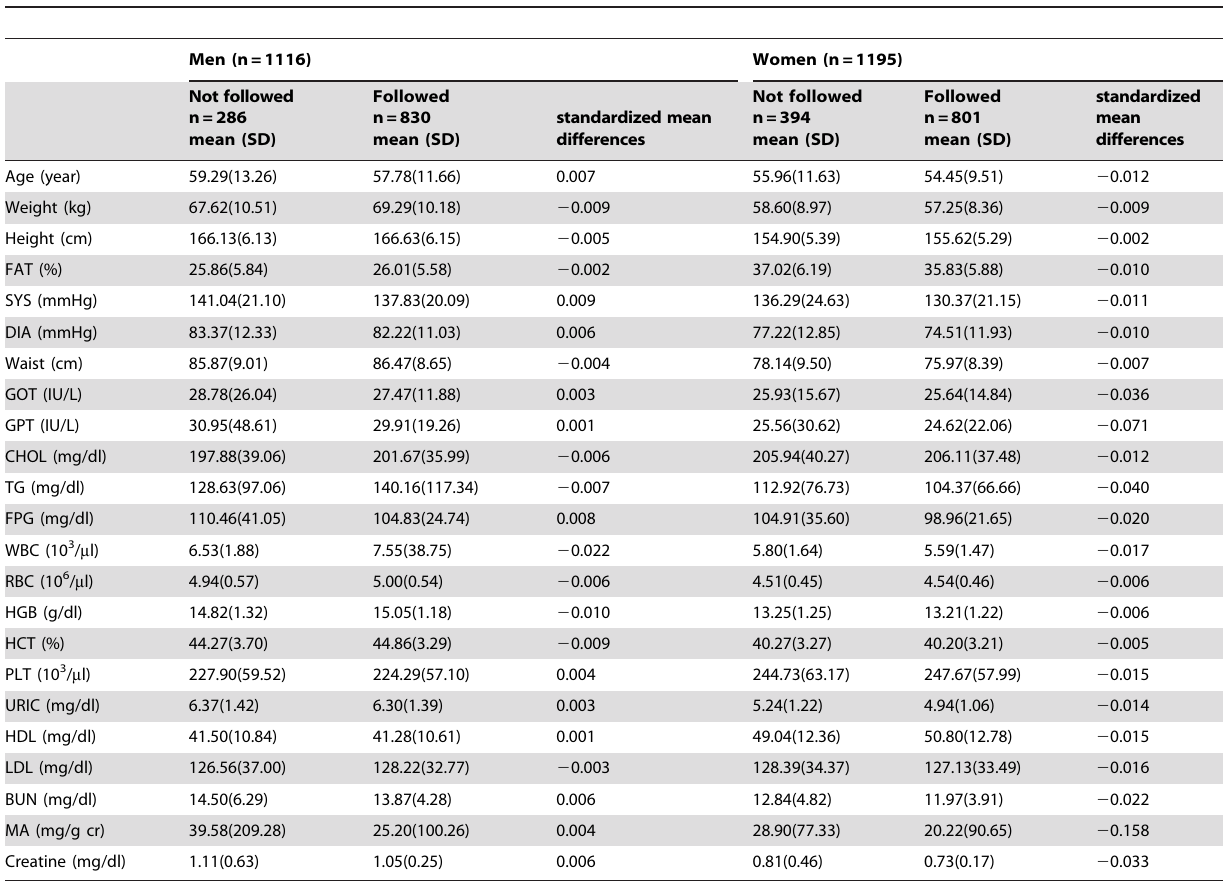
Table 1. Baseline characteristics in individuals who were followed up and those who were not according to